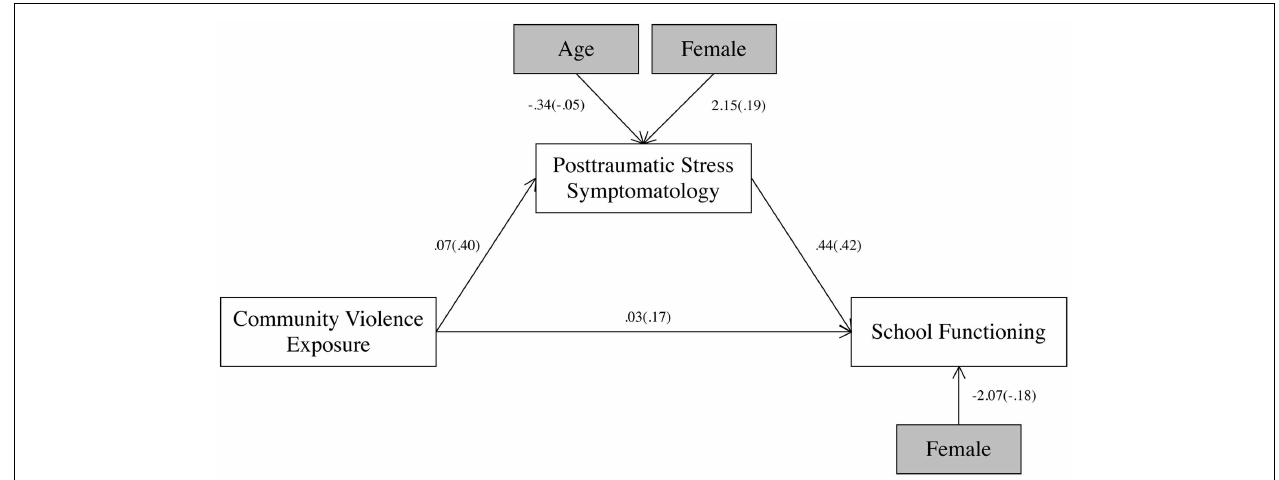
FIGURE 1 | Community violence, PTS symptoms, and school functioning problems . All paths were significant ( p < 0.05). Unstandardized path coefficients are listed, followed by standardized path coefficients in parentheses.